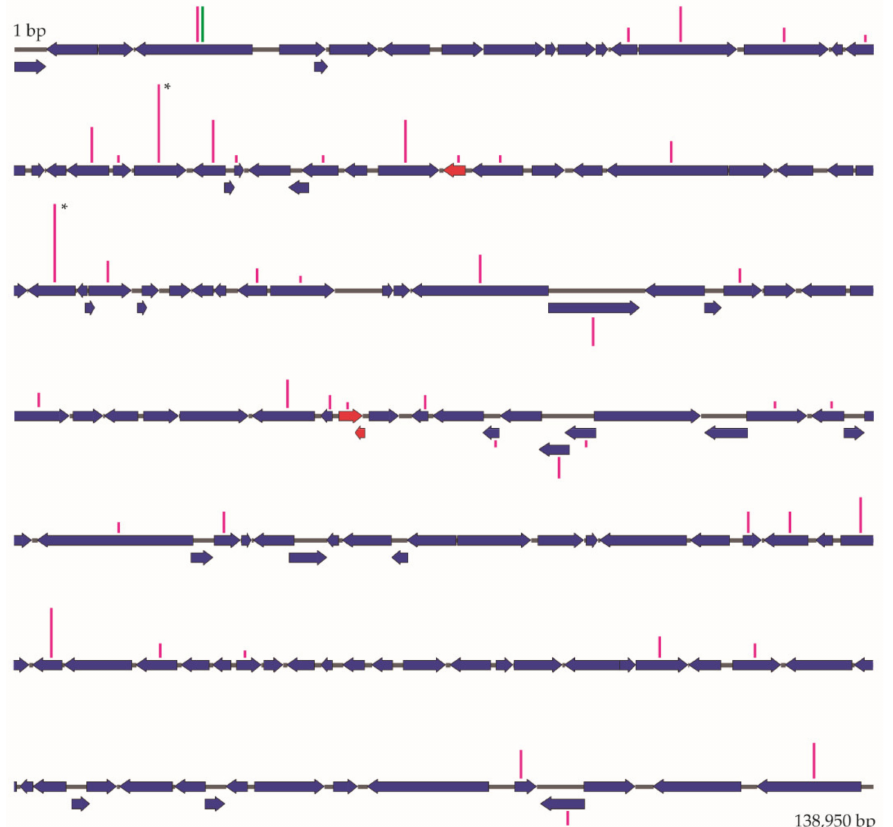
Figure 8. Schematic representation of ChinNPV-K genome ORFs. Vertical bars represent the number of cumulative SNPs in each ORF in pink for ChinNPV-K and green for ChinNPV-E, resulting in different heights according to the number of SNPs. Bars labelled with asterisks indicate the highest number of SNPs detected, which was 22 SNPs per ORF. Only the ChinNPV-K genome is depicted due to the high similarity between the ChinNPV-K and ChinNPV-E ORF length and distribution. The three ORFs in red represent ORFs that are not present in the ChinNPV genomes sequenced